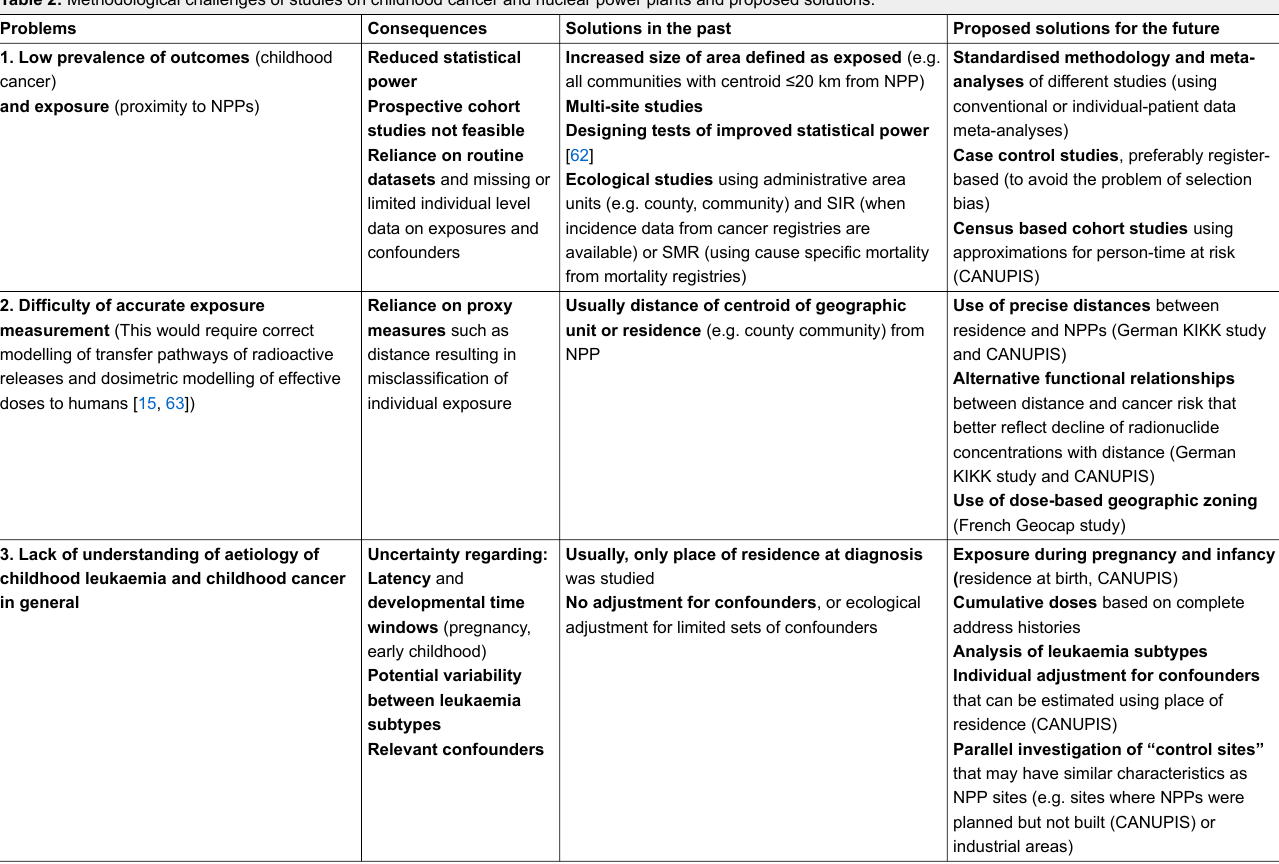
Table 2: Methodological challenges of studies on childhood cancer and nuclear power plants and proposed solutions.